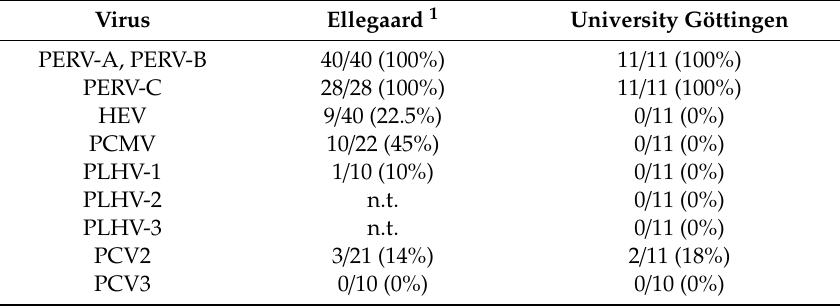
Table 4. Comparison of GöMP at Ellegaard and the University of Göttingen. Virus Ellegaard 1 University Göttingen PERV-A, PERV-B 40 / 40 (100%) 11 / 11 (100%) PERV-C 28 / 28 (100%) 11 / 11 (100%) HEV 9 / 40 (22.5%) 0 / 11 (0%) PCMV 10 / 22 (45%) 0 / 11 (0%) PLHV-1 1 / 10 (10%) 0 / 11 (0%) PLHV-2 n.t. 0 / 11 (0%) PLHV-3